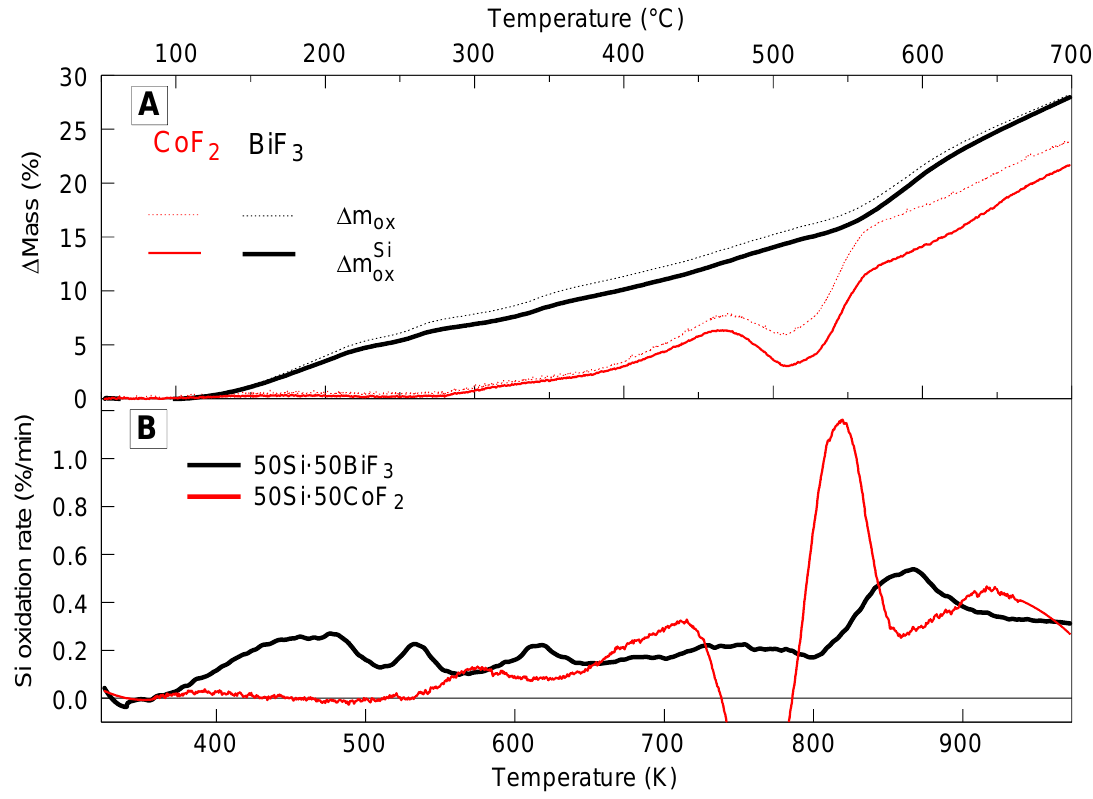
Figure 16. The ( A ) oxidative mass gain and corresponding ( B ) silicon oxidation rate of two-stage milled materials 50Si·50BiF 3 and 50Si·50CoF 2 .